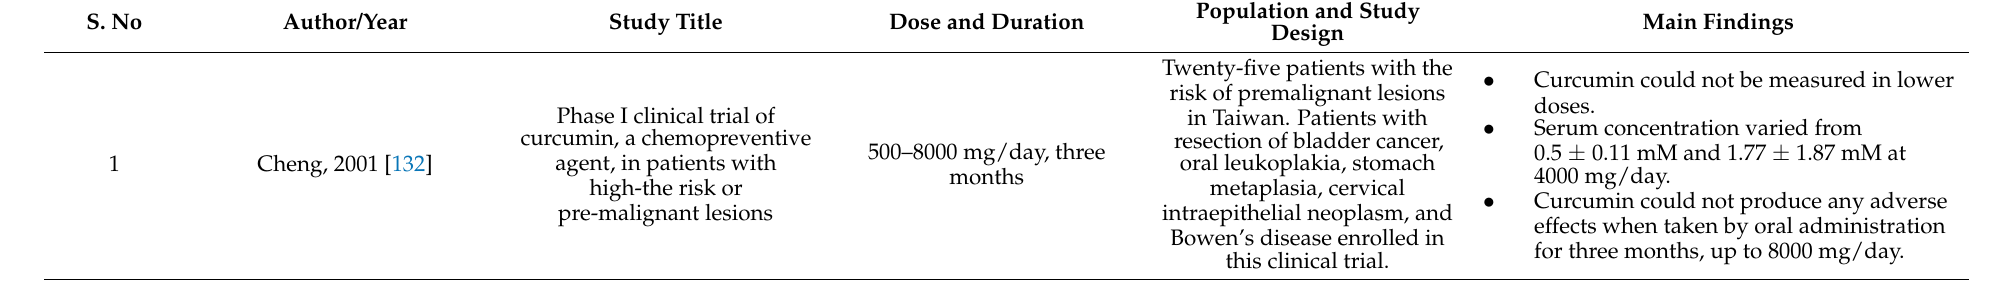
Table 5. Details of clinical trials of curcumin in the treatment of inflammatory bowel